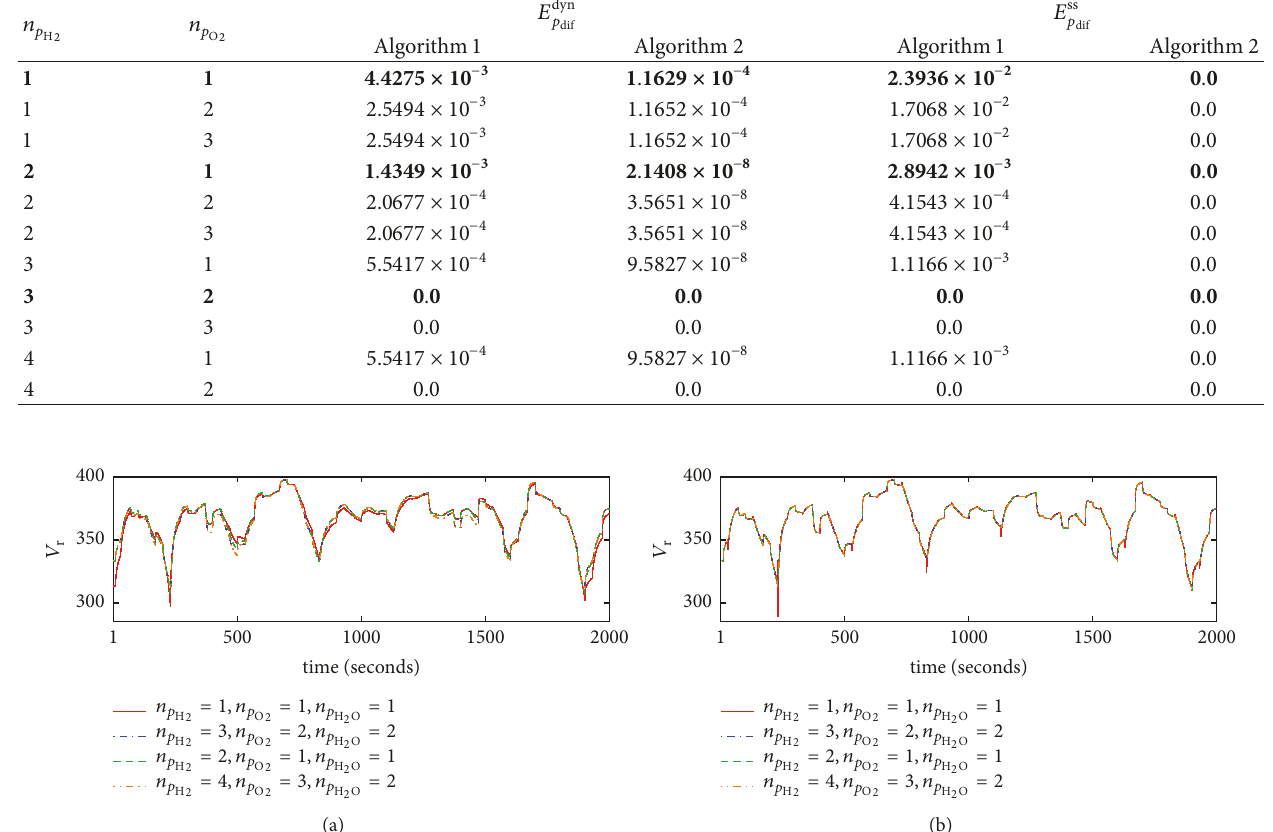
Table 14: The influence of the order of hydrogen and oxygen pressure models ( 𝑛 𝑝 error 𝐸 ss 𝑝 of the output variable 𝑝 dif . dif